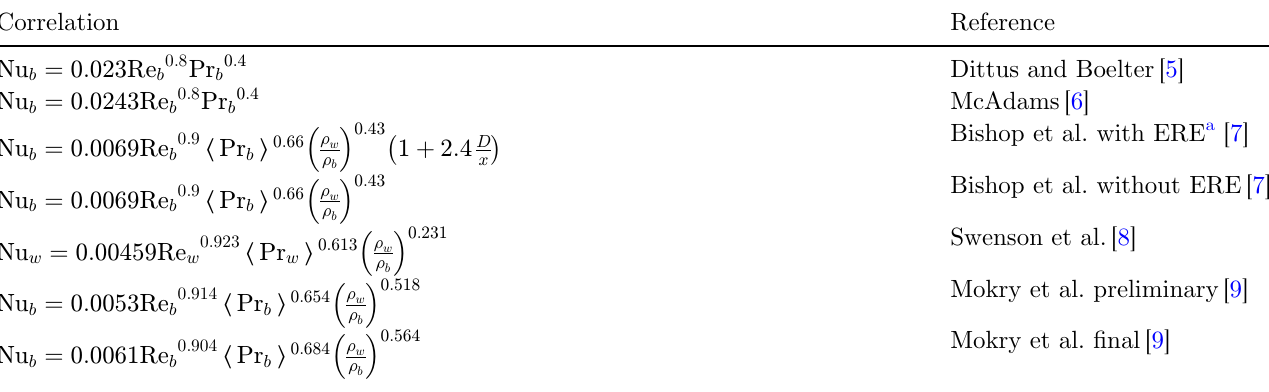
Table 1. Supercritical water heat-transfer correlations (HTCs).